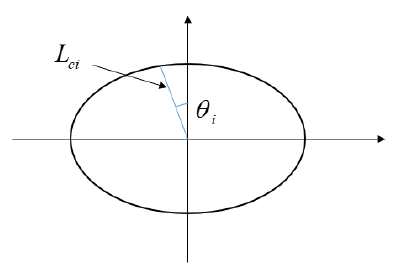
Figure 10. Schematic diagram of the ellipse.